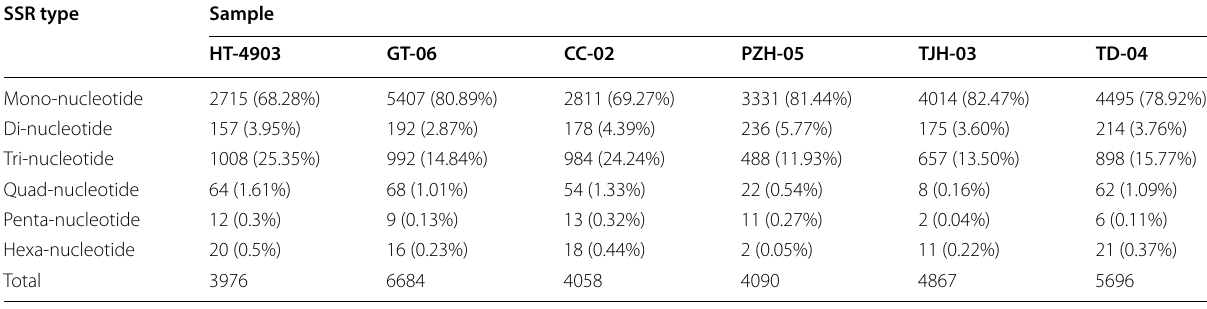
Table 4 Distribution of SSR loci in H. erinaceus HT-4903, GT-06, CC-02, PZH-05, TJH-03 and TD-04